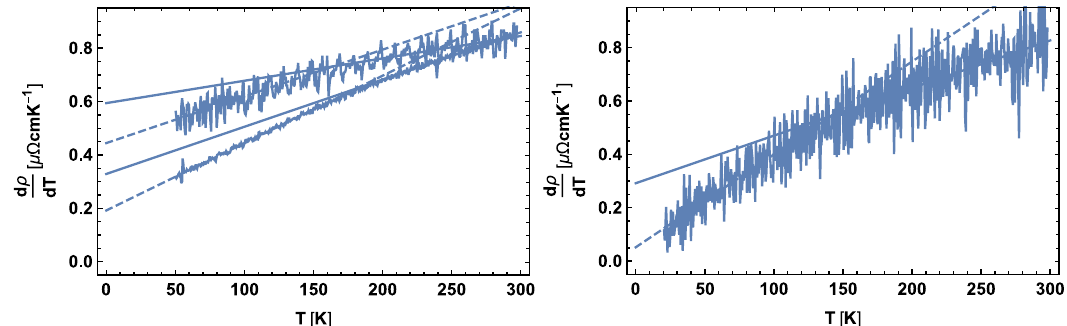
Fig. 2 Temperature derivative of the resistivity for overdoped LSCO. Left plots have p = 0.26 (top) and p = 0.29 (bottom). Right plot has p = 0.33. Data from 45 . Dashed lines are fi ts to a o + 2 b o T at low temperatures (as in 45 ), while solid lines are fi ts to a + 2 bT in the temperature range of 200 – 300 K.